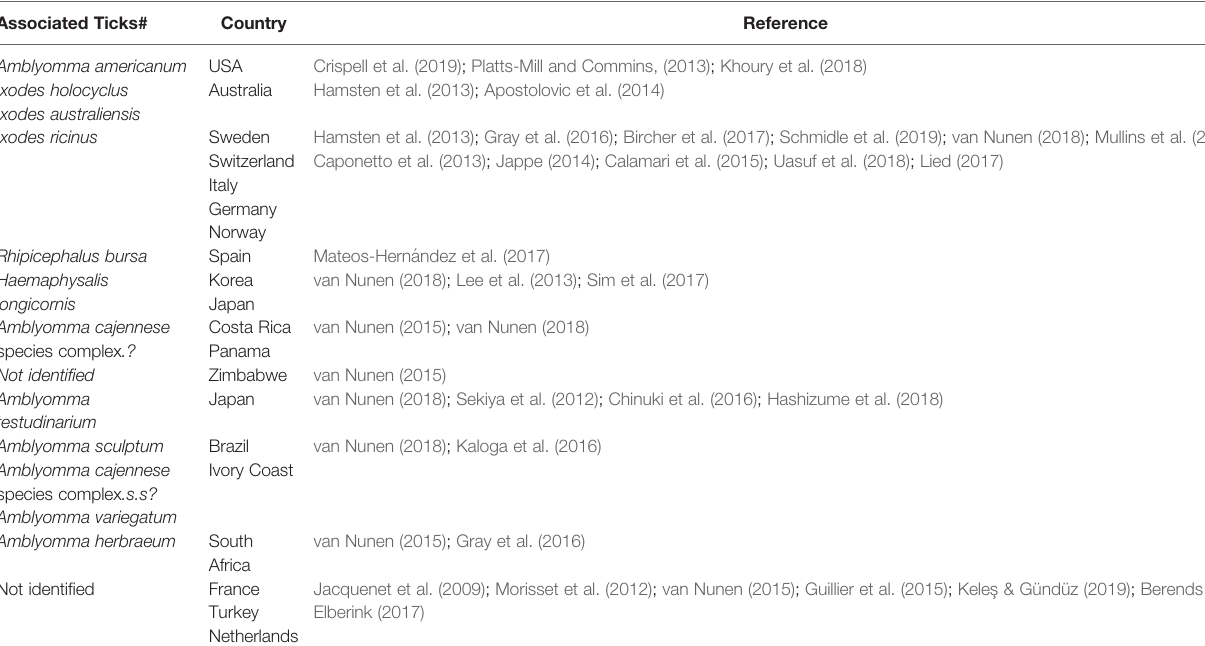
TABLE 1 | List of tick species reported to be associated with alpha-gal syndrome worldwide. Associated Ticks#